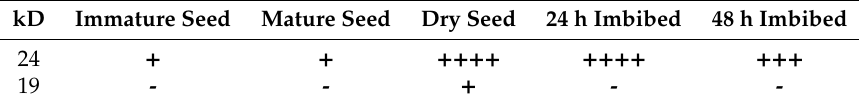
Table 2. Molecular weight and relative abundance of seed membrane phosphoproteins. Gel band staining ranked per lane in quartiles of intensity indicated as ++++ > +++ > ++ > + and not detected (-).